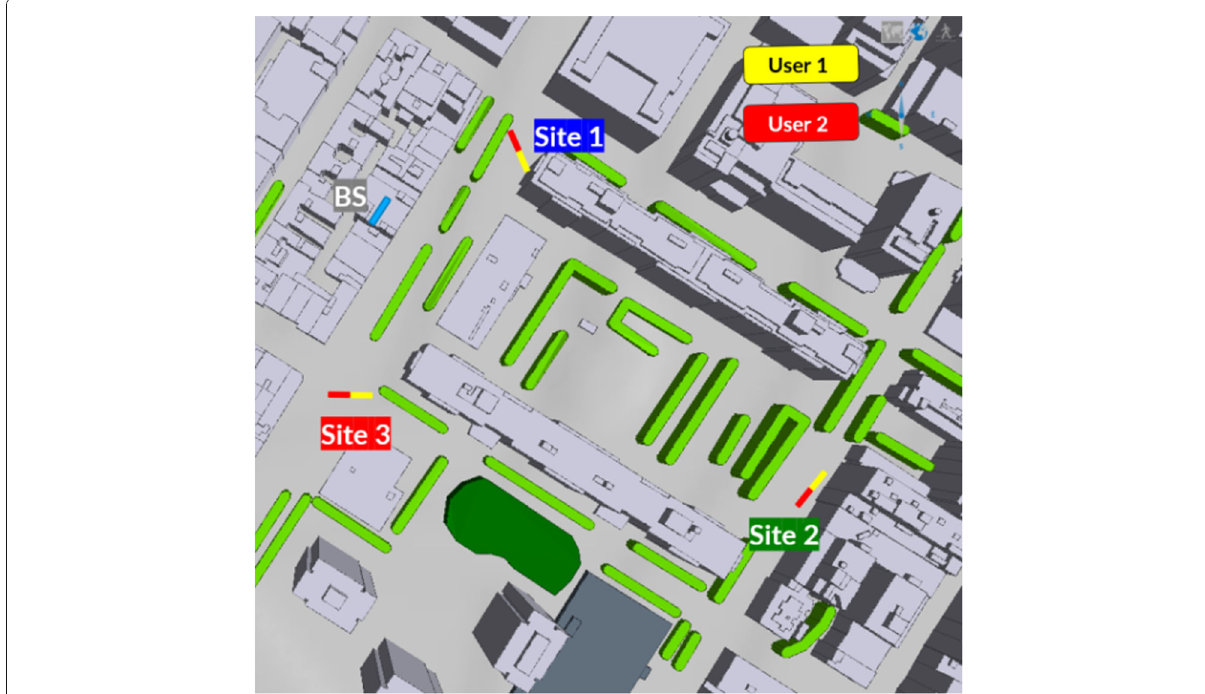
Fig. 1 Single-cell macro base station